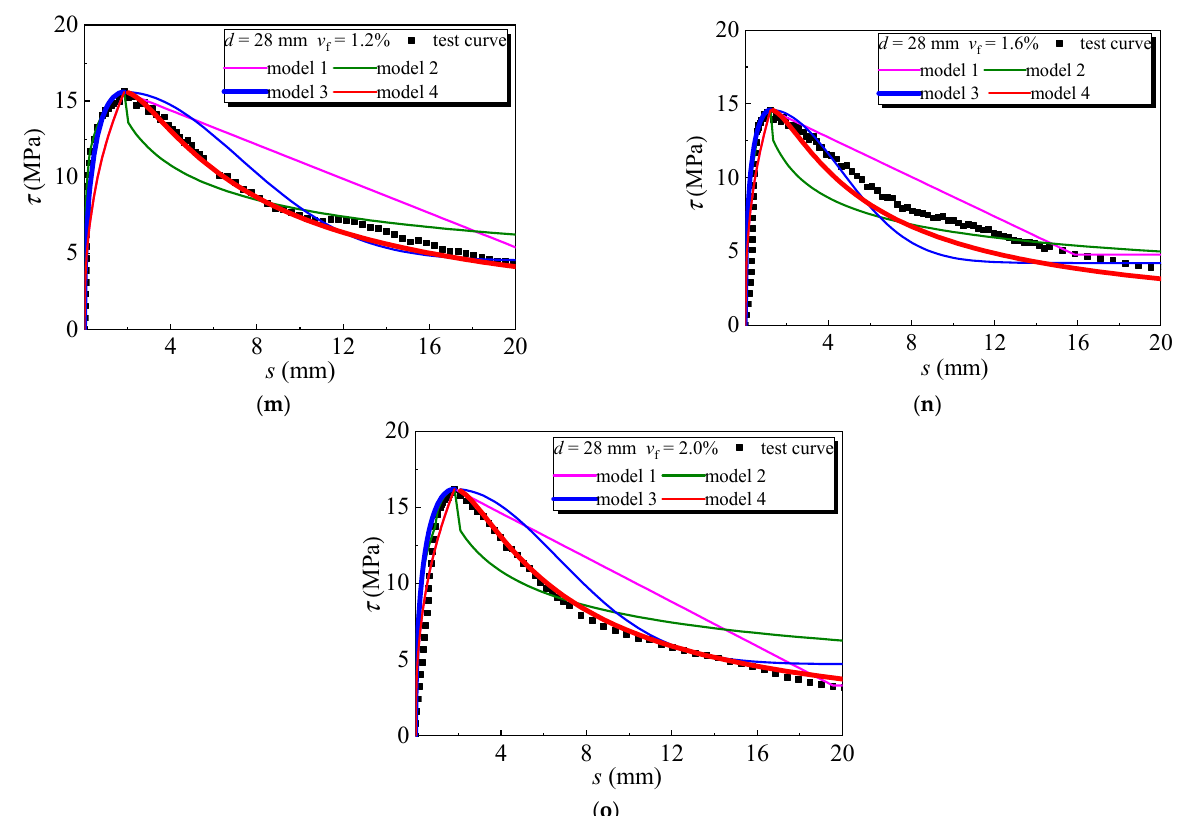
Figure 16. Comparison for bond stress-slip curves with calculation models: d = 14 mm, ( a ) v f = 0%, ( b ) v f = 0.8%, ( c ) v f = 1.2%, ( d ) v f = 1.6%, ( e ) v f = 2.0%; d = 20 mm, ( f ) v f = 0%, ( g ) v f = 0.8%, ( h ) v f = 1.2%, ( i ) v f = 1.6%, ( j ) v f = 2.0%; d = 28 mm, ( k ) v f = 0%, ( l ) v f = 0.8%, ( m ) v f = 1.2%, ( n ) v f = 1.6%, ( o ) v f = 2.0%.